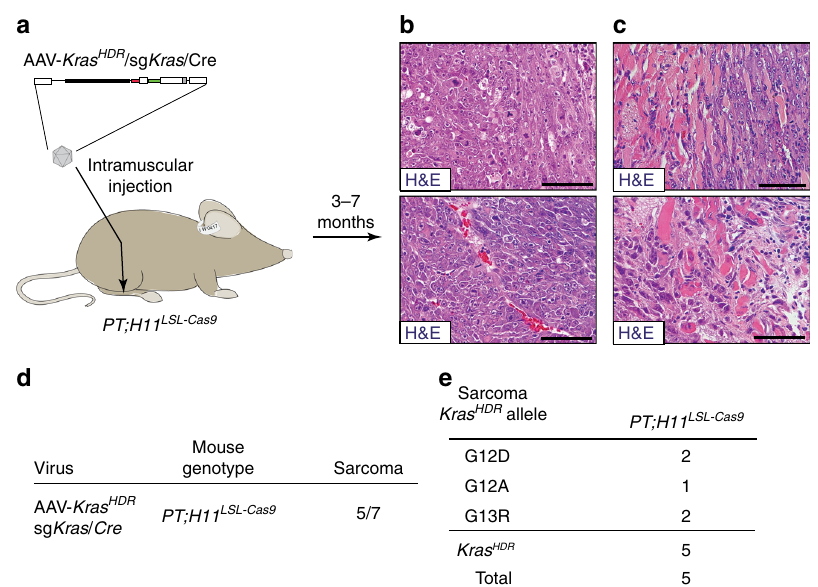
Fig. 5 Introduction of mutant Kras variants into muscle cells using AAV/Cas9-mediated HDR induces invasive sarcoma. a Schematic of intramuscular administration of AAV- Kras HDR /sg Kras / Cre (1.6 × 10 11 vector genomes per mouse) into the gastrocnemii of PT;H11 LSL-Cas9 mice to induce sarcomas. b , c Histology of stereotypical sarcoma ( b ) and invasive sarcoma ( c ) initiated by intramuscular administration of AAV- Kras HDR /sg Kras / Cre into the gastrocnemii of PT;H11 LSL-Cas9 mice. Scale bars = 75 µ m. d Sarcoma incidence in PT;H11 LSL-Cas9 mice 3 – 7 months after intramuscular administration of AAV- Kras HDR /sg Kras / Cre . Incidence represents the number of mice that developed sarcomas out of the total number of mice injected. e HDR-generated oncogenic Kras alleles in sarcomas. Number of tumors with each allele is indicated. Alleles not identi fi ed in any sarcomas are not